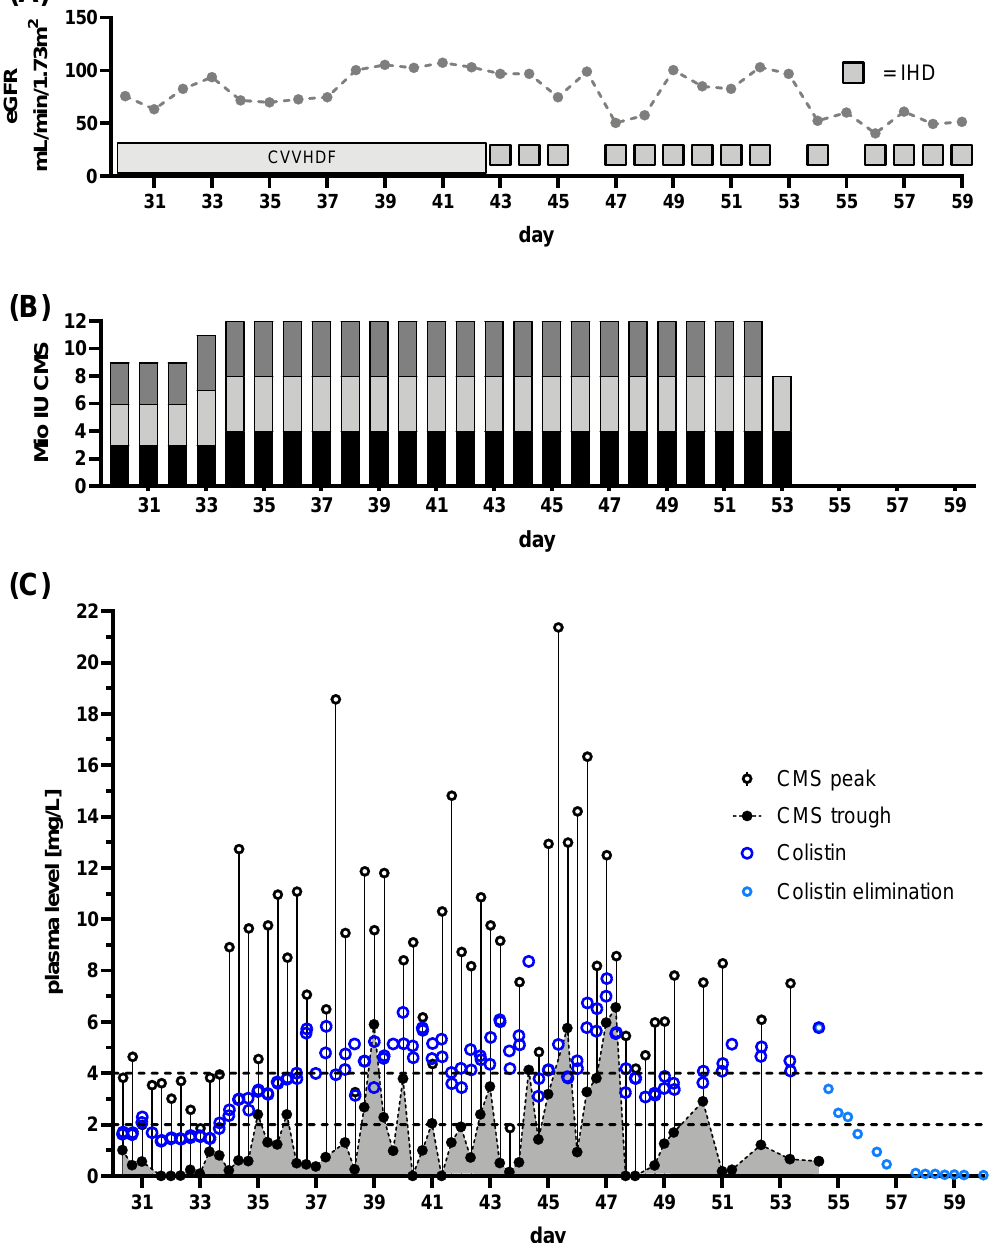
Figure 7. Renal function, dose regimen and drug plasma levels of patient 5: a total of 132 samples were analyzed (colisthimethate sodium (CMS) peak n = 60, CMS trough n = 60, Colistin peak n = 59, Colistin trough n = 59). ( A ) estimated glomerular filtration rate (eGFR) derived from serum creatinine levels and renal replacement therapy via continuous venovenous hemodiafiltration (CVVHDF) or intermittent hemodialysis (IHD). ( B ) Dose regimen used. Shaded blocks depict the particular individual doses each day. ( C ) Time course of CMS trough and peak levels along with Colistin levels. The CMS reservoir is indicated by the area gray shaded portion of panel ( C ). Colistin elimination was measured by continuing monitoring after the end of treatment (light blue dots) and the individual fitted elimination is plotted in Figure 1A. Target range for Colistin plasma levels is indicated by dashed lines.